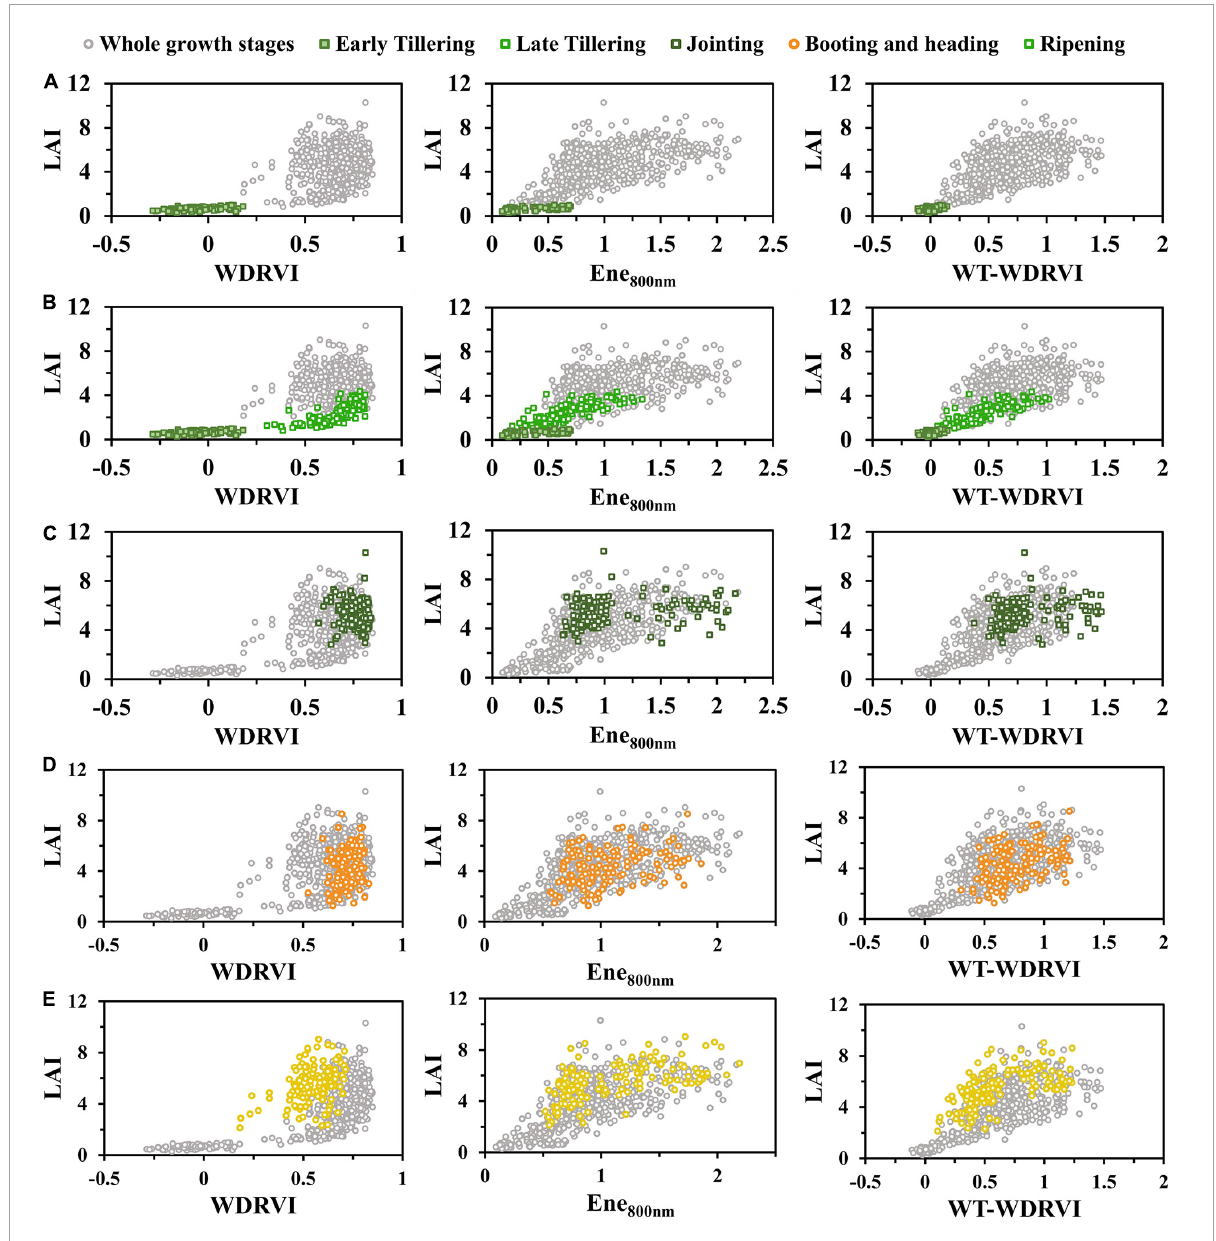
FIGURE9 WDRVI vs LAI, Ene 800 nm vs LAI, and WT-WDRVI vs LAI of whole growth stages. (A) Early tillering. (B) Late tillering. (C) Jointing. (D) Booting and heading. (E) Ripening. To highlight the difference in texture features, the early tillering and late tillering stages are displayed separately.